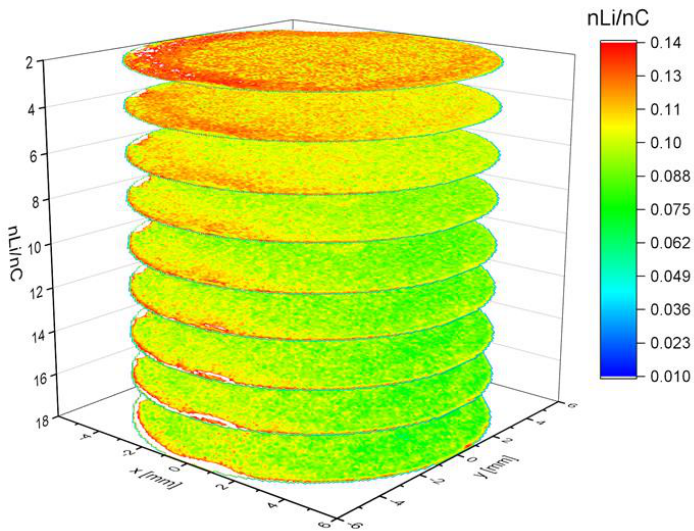
Figure 5. 3D illustration of lithium concentration within a full lithiated graphite electrode at 0.01 V.